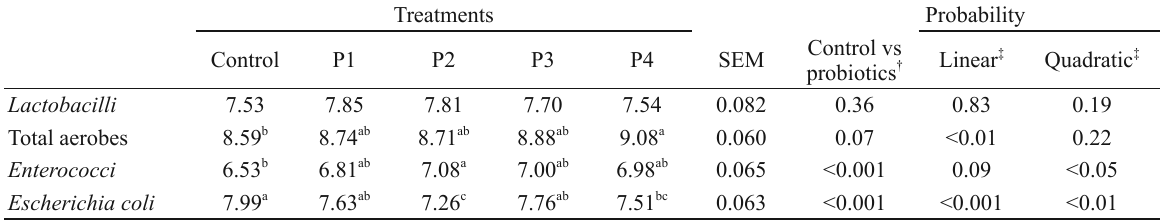
Cecal bacterial counts (log CFU g -1 digesta) of 6-week old broilers fed diets containing either no probiotics (control) 10 or 0.005%, 0.01%, 0.015% and 0.02% of probiotics (P1, P2, P3 and P4, respectively). All data were obtained from four birds per treatment. Treatments Probability Control vs Control P1 P2 P3 probiotics